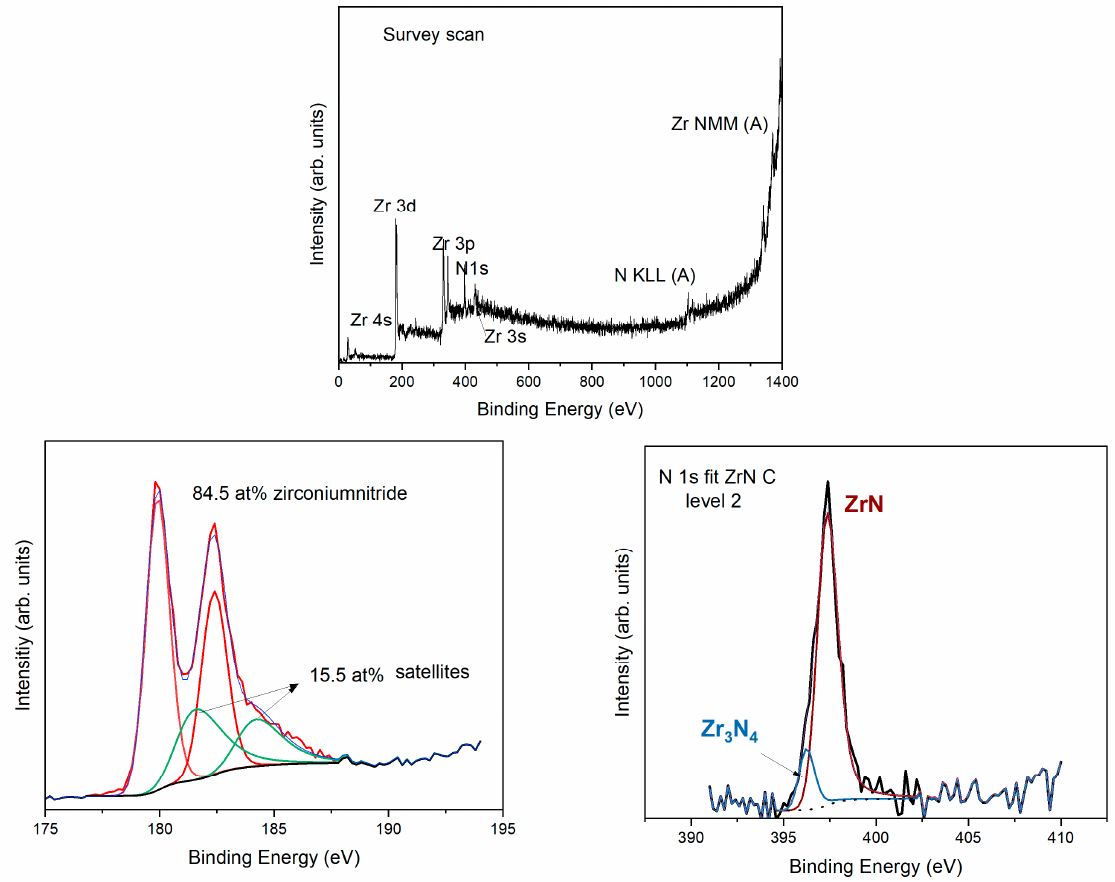
Figure 6. Survey scan of sample ZrN C (top spectrum) after Ar+ etch-cleaning of 2 sec (level 2 of acquisition) with identification of both photoelectrons and Auger peaks (A). (Bottom left) Zr 3d region after fit and (bottom right) N 1s region after fit for sample ZrN C.